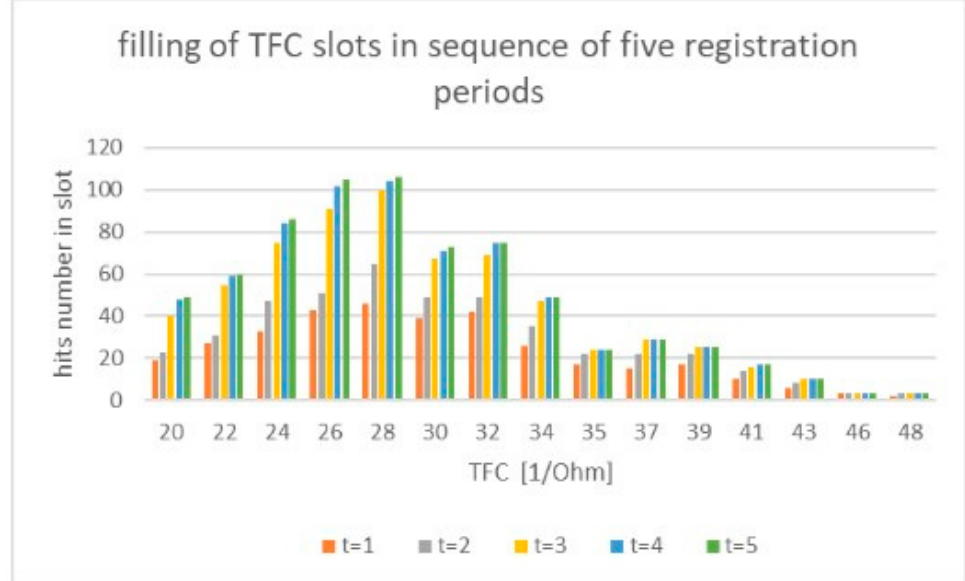
Figure 2. Stepped registration of TFC values in measurement intervals denoted as t in the figure.